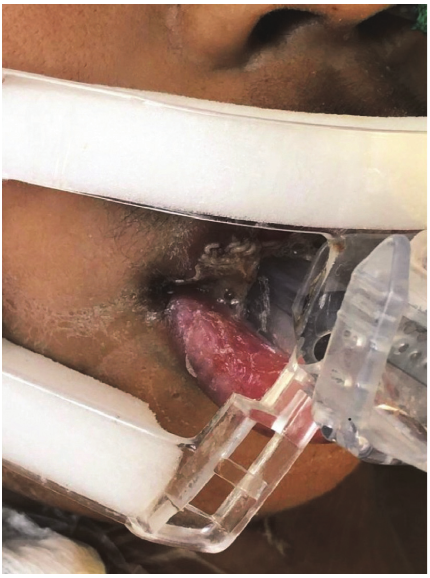
Figure 1: Patient’s with nosocomial myiasis. Presence of larvae between upper lip and